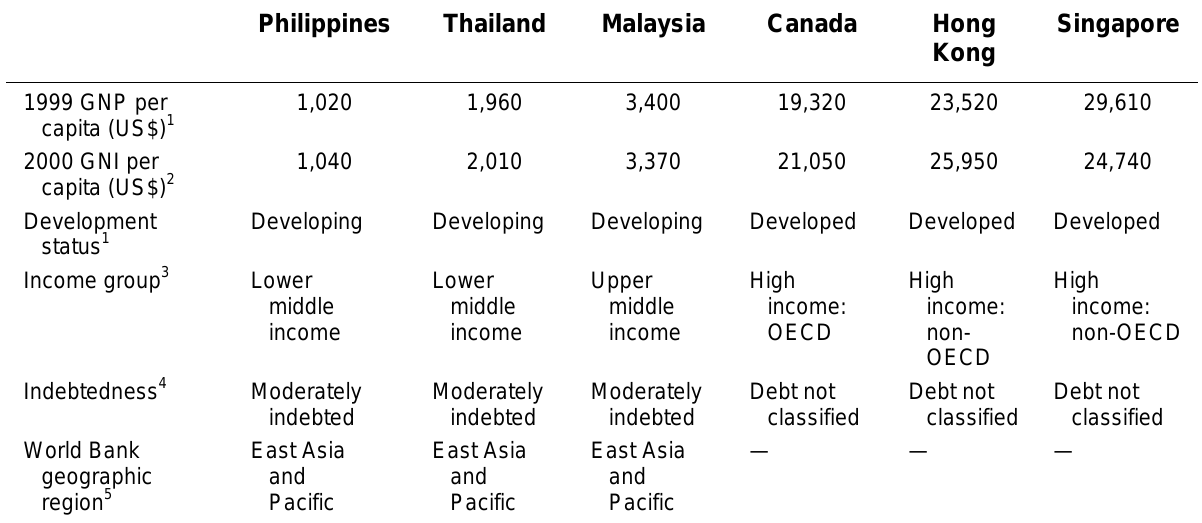
World Bank Development Indicators, by